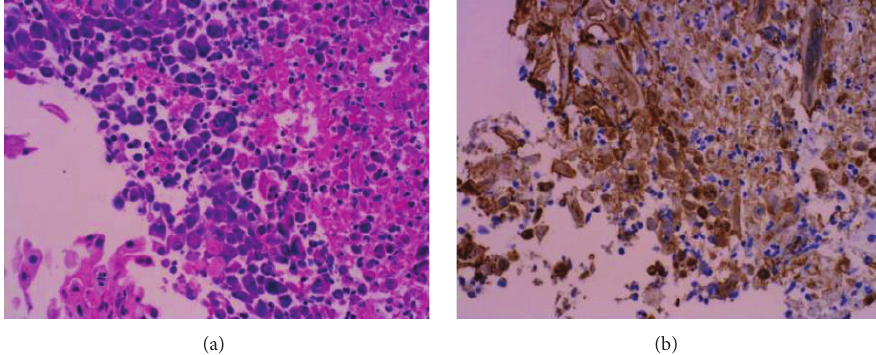
Figure 2: (a) H&E of the esophagus showing mucosal necrosis with smudgy nuclear chromatin and multinucleation, highly characteristic of HSV infection (400x). (b) Showing positive immunohistochemistry for HSV